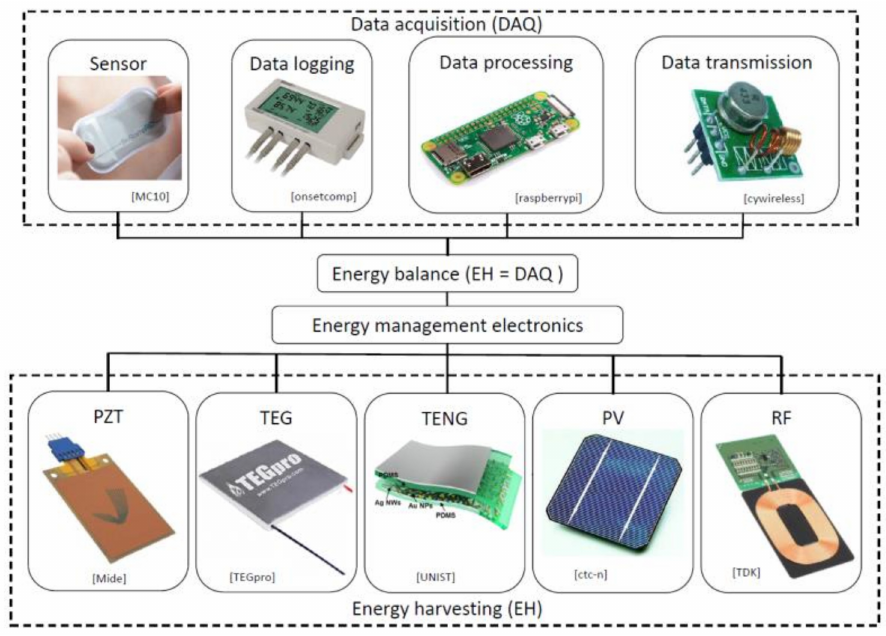
Figure 1. EH integration in autonomous devices with sensors and the respective data processing and communication modules, enabling the creation of sensor networks